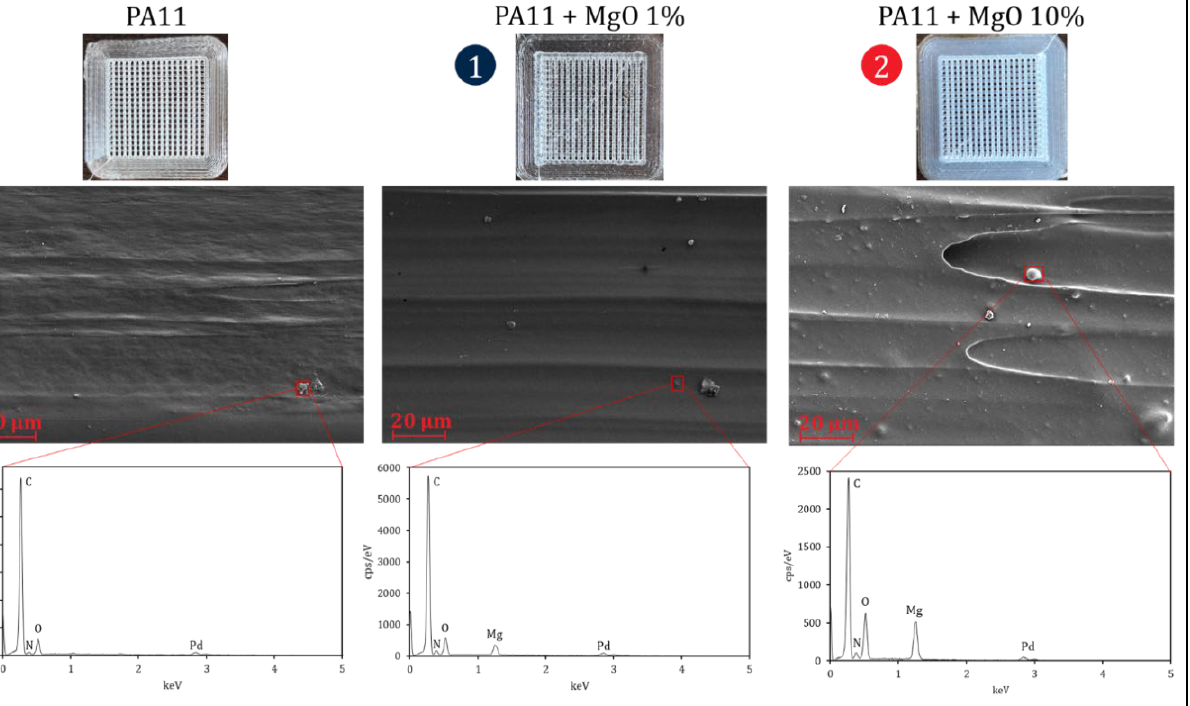
Figure 26. Membrane spacer characterization with SEM/EDX. Antibacterial assays were done on raw PA11 and PA11 + MgO 5% wt. (process 2)